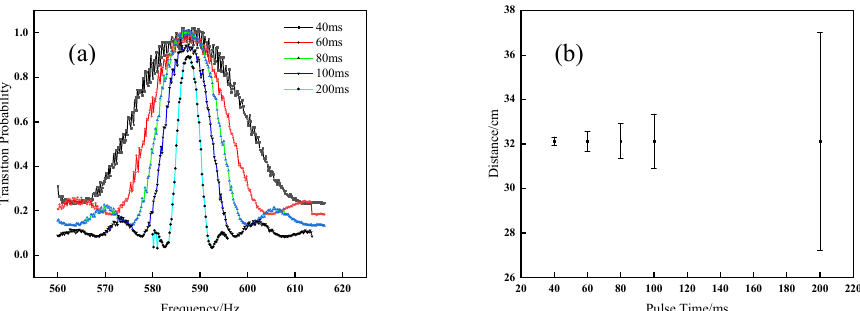
Figure 6. Influence of low-frequency pulse time on transition curves and atomic moving distance; ( a ) low-frequency transition curves with different low-frequency pulse time; ( b ) atomic moving distance with different low-frequency pulse time.